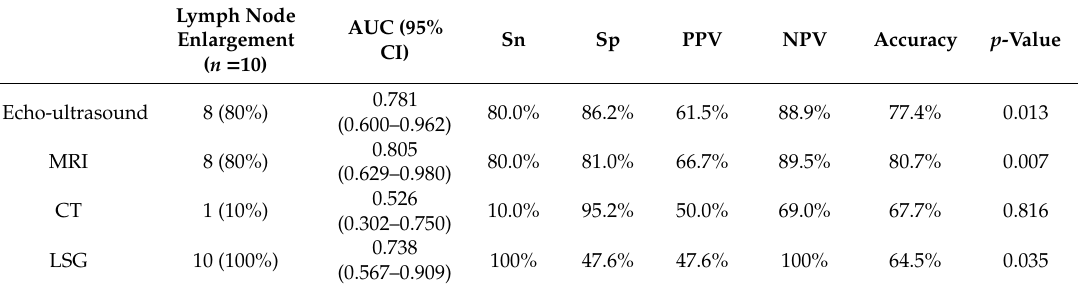
Table 4. The values of the receiver operating characteristic curve (ROC) analysis to detect lymph node enlargements (calculated area under curve, sensitivity, specificity and predictive values) for di ff erent diagnostic